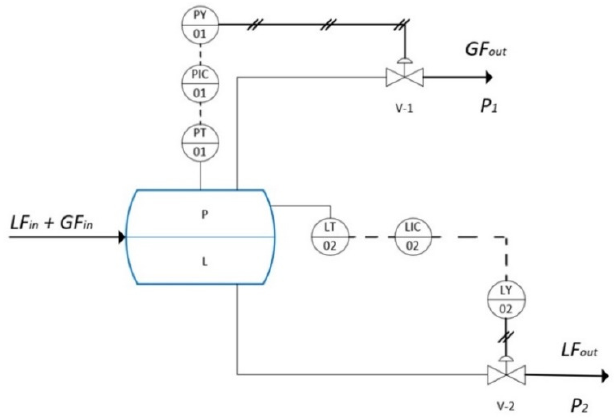
Figure 1. P&ID diagram of a biphasic separator.